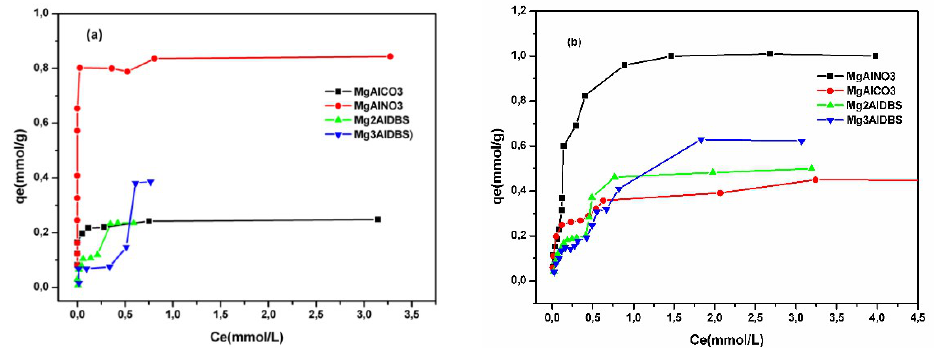
Figure 5. Isotherms data of the dye adsorption ( a ) amaranth and ( b ) DGB by MgAlCO3, MgAlNO3, Mg2AlDBS and Mg3AlDBS adsorbents, qe is the amount of dye adsorbed at equilibrium (mmol·g −1 ).